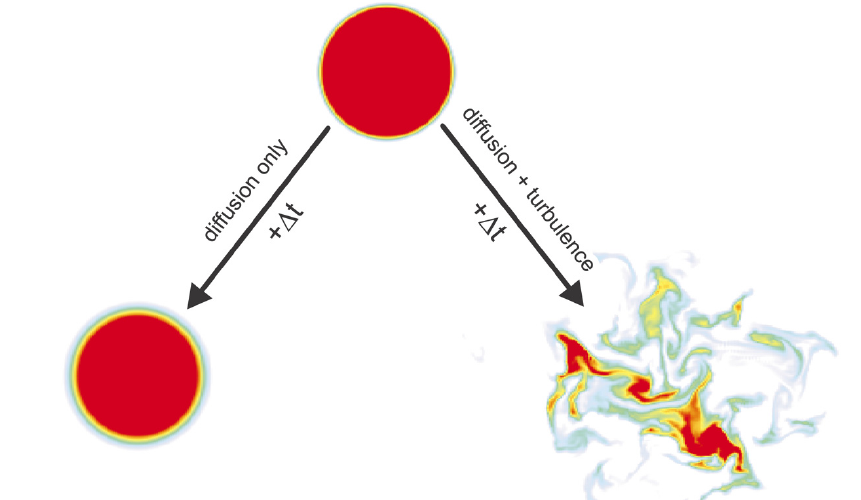
Figure 2 . The effect of turbulence compared to mere molecular diffusion, adapted from Smyth and Moum [49]. At the top, the assumed initial state is depicted (a circular region of nearly homogeneous concentration) while the pictures on the bottom show two numerical solutions of the equations of motion obtained in the case of a motionless fluid (left) and in the case of fully developed, two-dimensional turbulence (right). Note the difficulty of finding smooth concentration gradients that would indicate the direction towards the gas source in the distribution on the